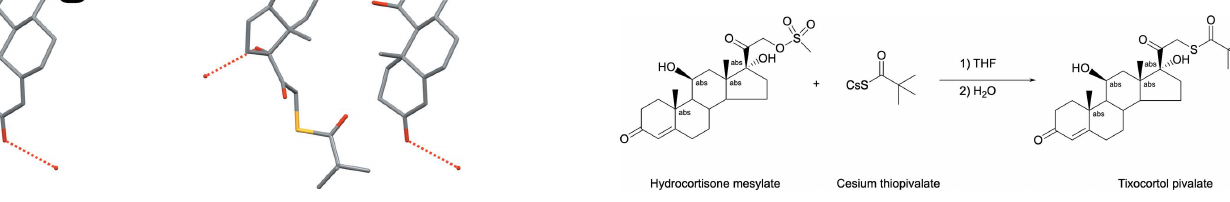
Figure 6 Reaction scheme for the synthesis of tixocortol pivalate.